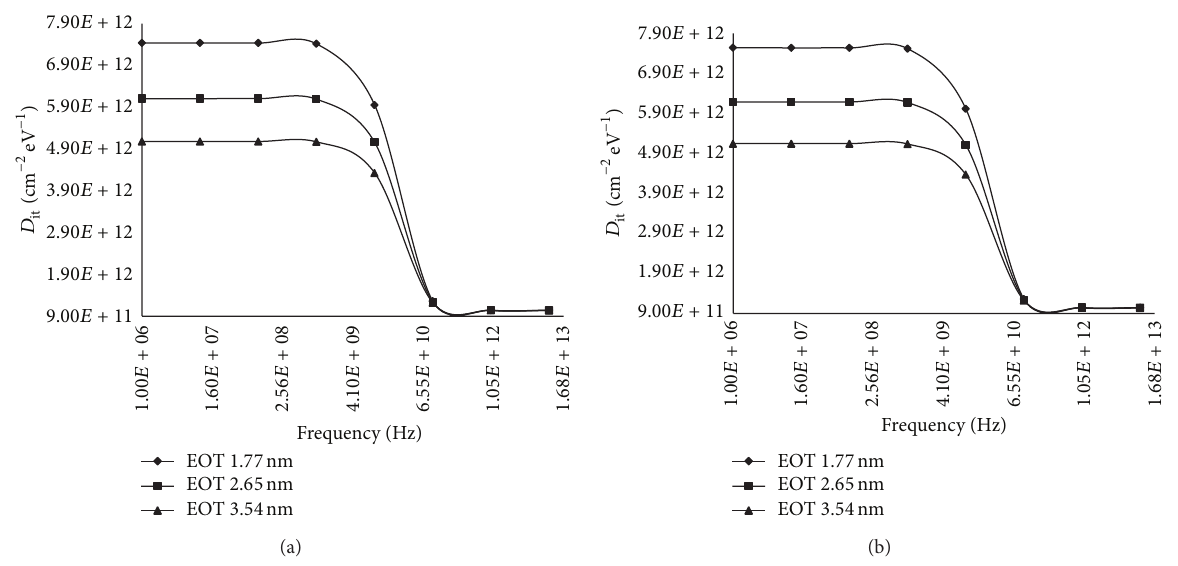
Figure 6: 𝐷 and frequency for (a) ZrO 2 and (b) HfO 2 at different EOT. it